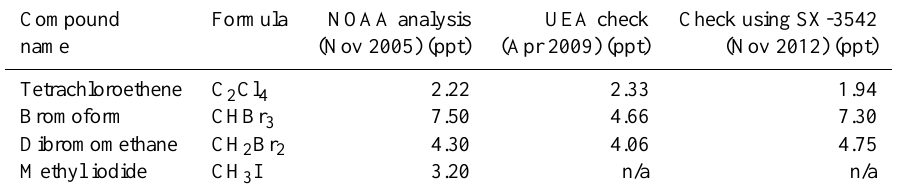
Table 2c. AAL-70424 used at Bukit Atur (May 2009 to January